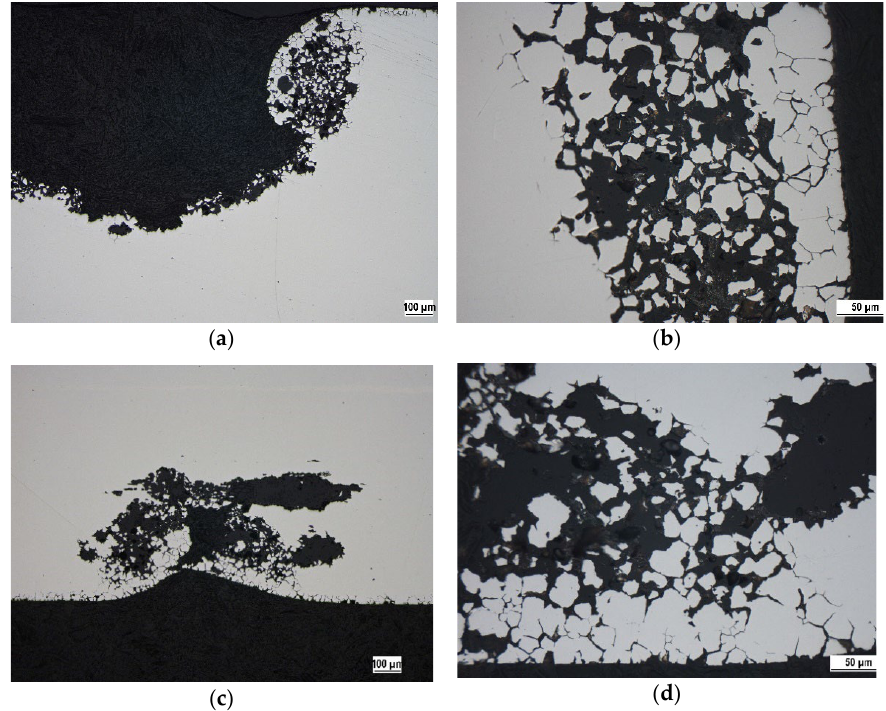
Figure 7. OM micrographs of the corrosion pits edges—SP specimen after 24 h exposure in 1 M Cl − solution (represented by 5 wt % FeCl 3 solution), cross section: ( a ) 20 ± 3 ◦ C, magnification 100 × ; ( b ) 20 ± 3 ◦ C, magnification 400 × ; ( c ) 50 ◦ C, magnification 100 × ; ( d ) 50 ◦ C, magnification 400 ×